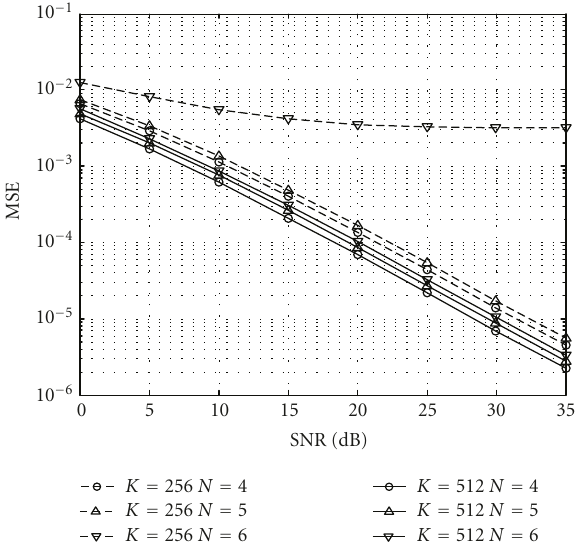
Figure 5: Impact of the relay number on the MSE